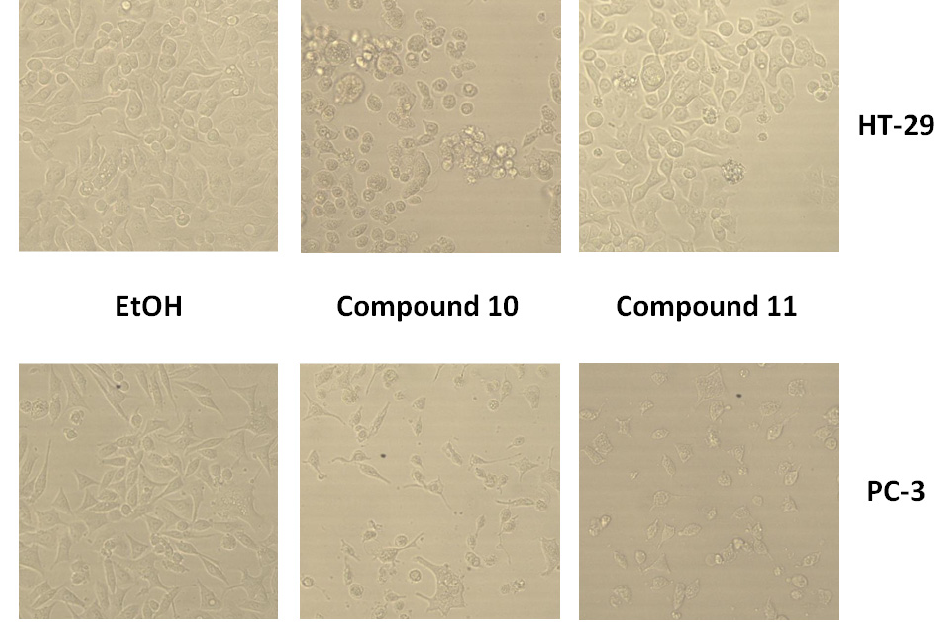
Figure 3. Effect of tested compounds on the morphology of HT-29 and PC-3 cells. Images obtained with an inverted phase contrast microscope (200×) after 24 h exposure of the cells to 25 μ M (+)- 10 or 11 .